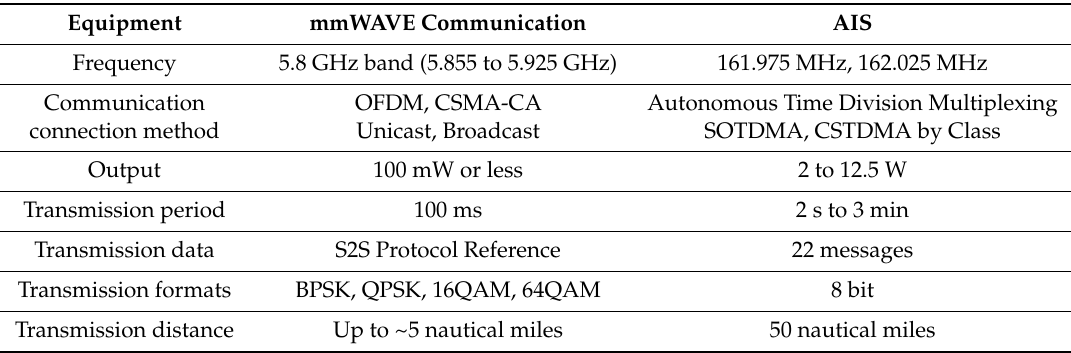
Table 1. Comparison of characteristics of mm WAVE communication and AIS.